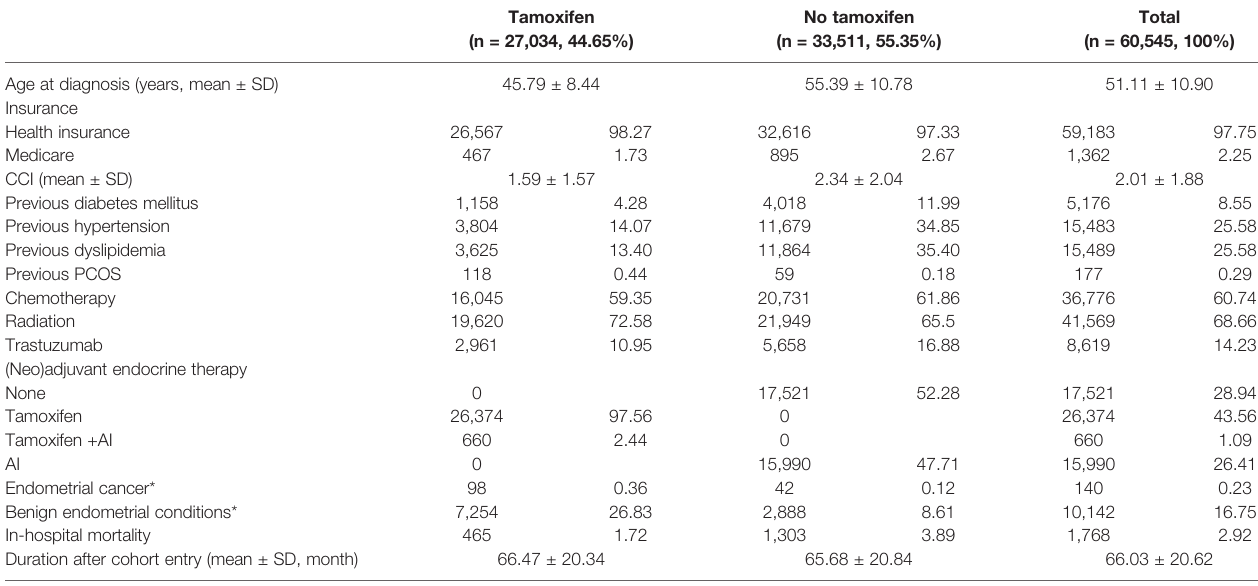
TABLE 1 | Baseline characteristics of the study